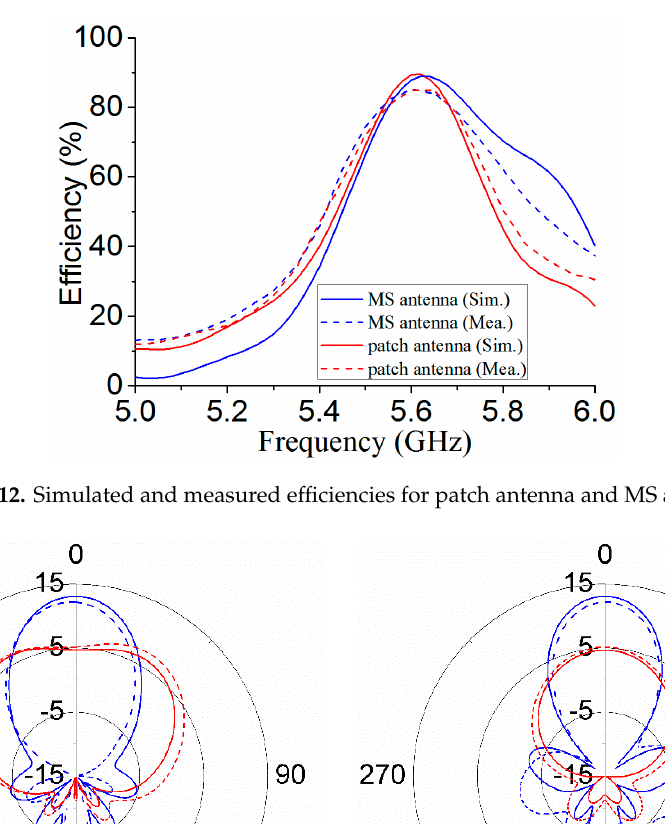
Figure 12. Simulated and measured efficiencies for patch antenna and MS antenna.